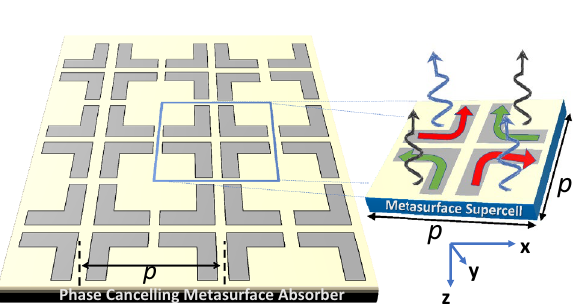
Figure 4. Schematic illustration of phase-compensated metasurface absorber which is formed by periodic arrangement of the folded four-element supercells. Inset shows the supercell structure and the explanation of the phase cancellation phenomenon. Illustrations were created in Microsoft Powerpoint 365 [https:// www. micro soft. com/ en- ww/ micro soft- 365/ power